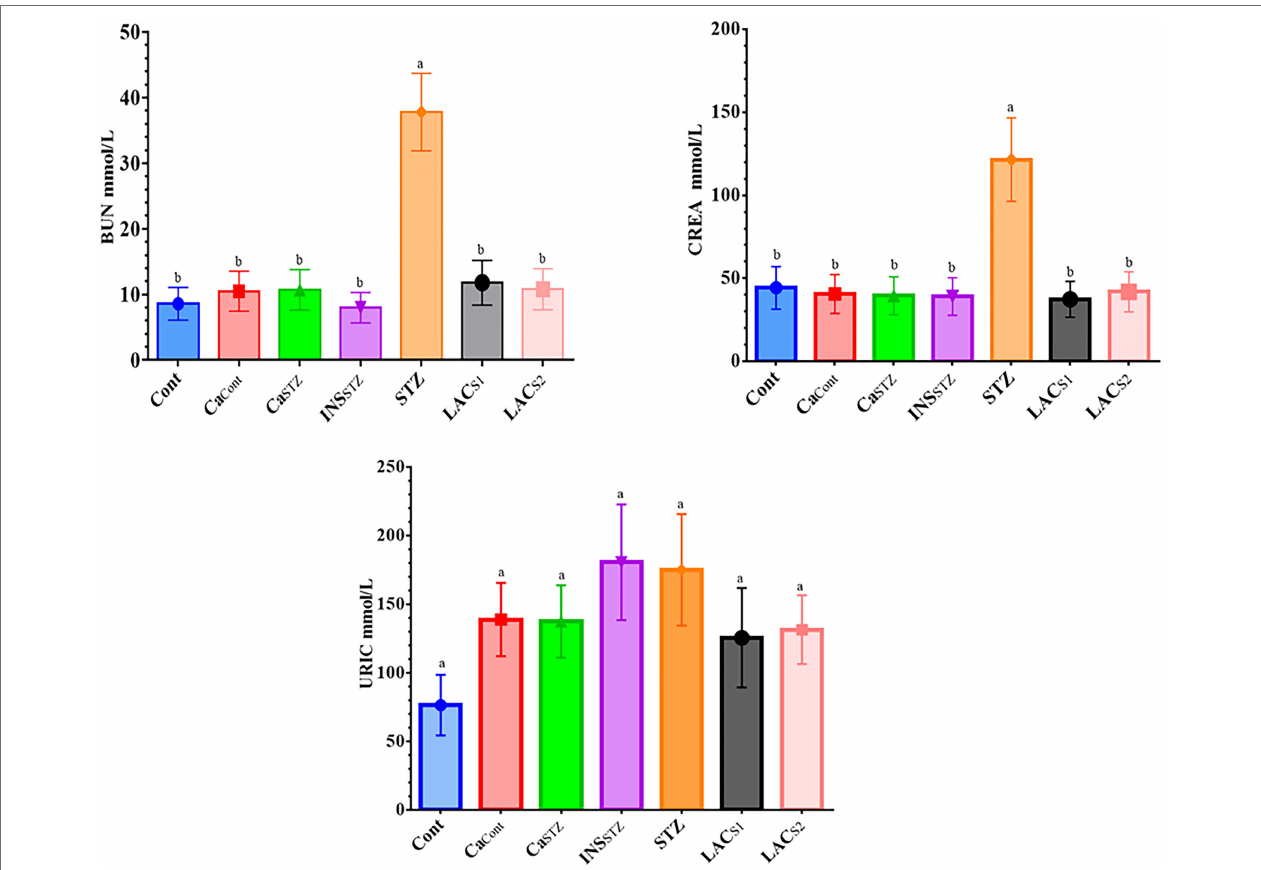
FIGURE 6 | Assessment of renal functions. Cont , control; Ca Cont , camel milk control; Ca STZ , camel milk with streptozotocin; INS STZ , insulin with streptozotocin; STZ , streptozotocin; LAC SI , KLDS 1.0727 with streptozotocin; LAC S2 , KLDS 1.0373 with streptozotocin. Result are given in triplicate as mean ± SD. Different letters indicate significant differences among groups ( p < 0.05). BUN, uric nitrogen; CREA, creatinine; URIC, uric